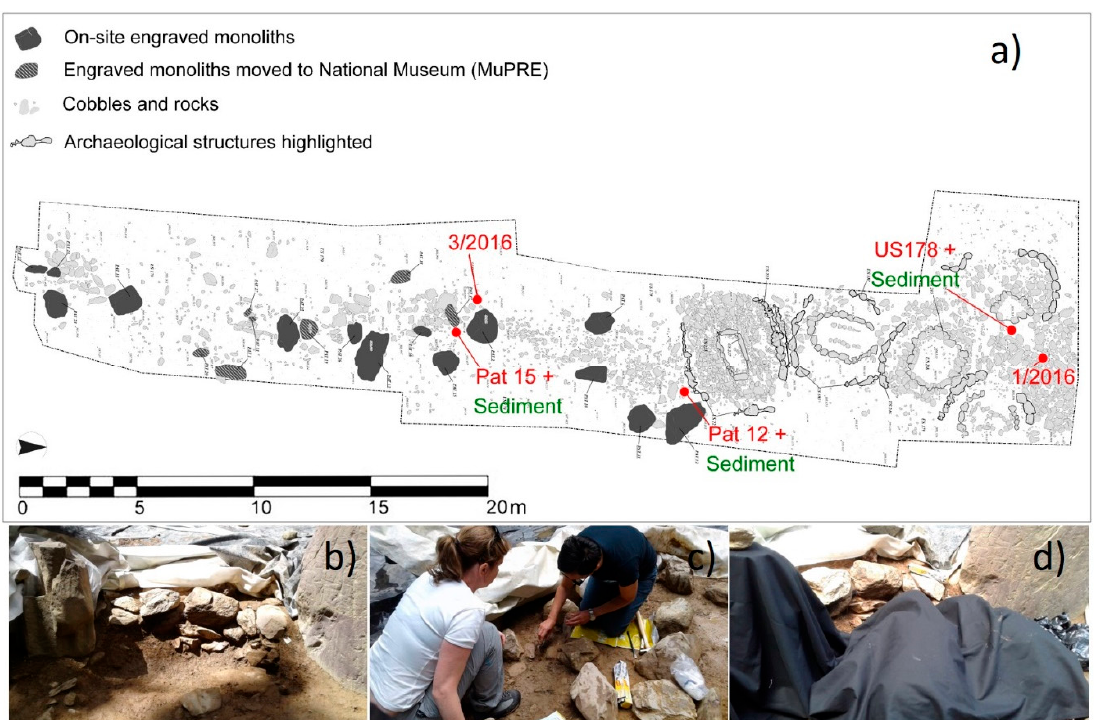
Figure 3. ( a ) Site map with sampling points; ( b ) detail of sample US178; ( c ) during the sampling operation under the sunlight and under the dark ( d ).